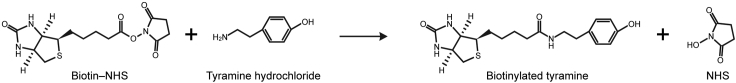
Chemical formula to produce biotin-tyramine